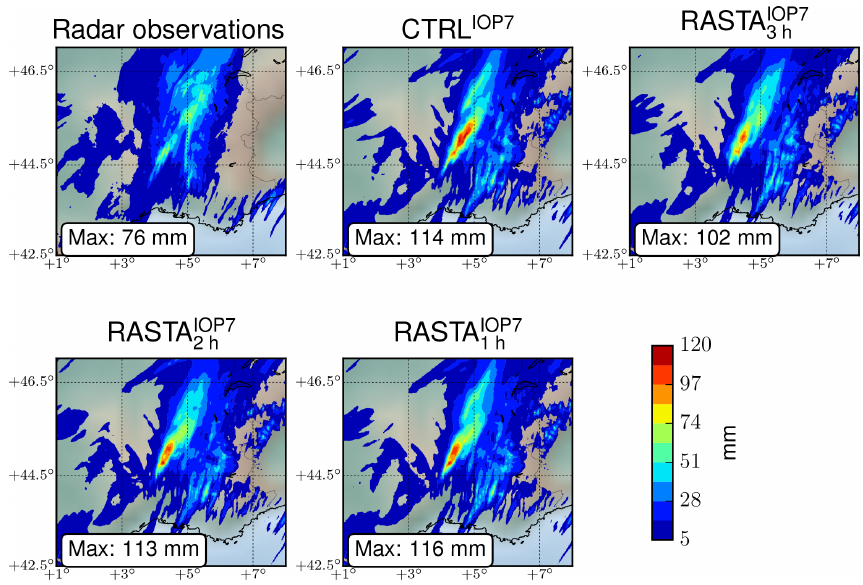
Figure 8. Maps of 11h accumulated rainfall between 07:00 and 18:00UTC on 26 September 2012 (IOP7a) for radar observations, the CTRL IOP7 , RASTA IOP7 , RASTA IOP7 , RASTA IOP7 3h 2h 1h